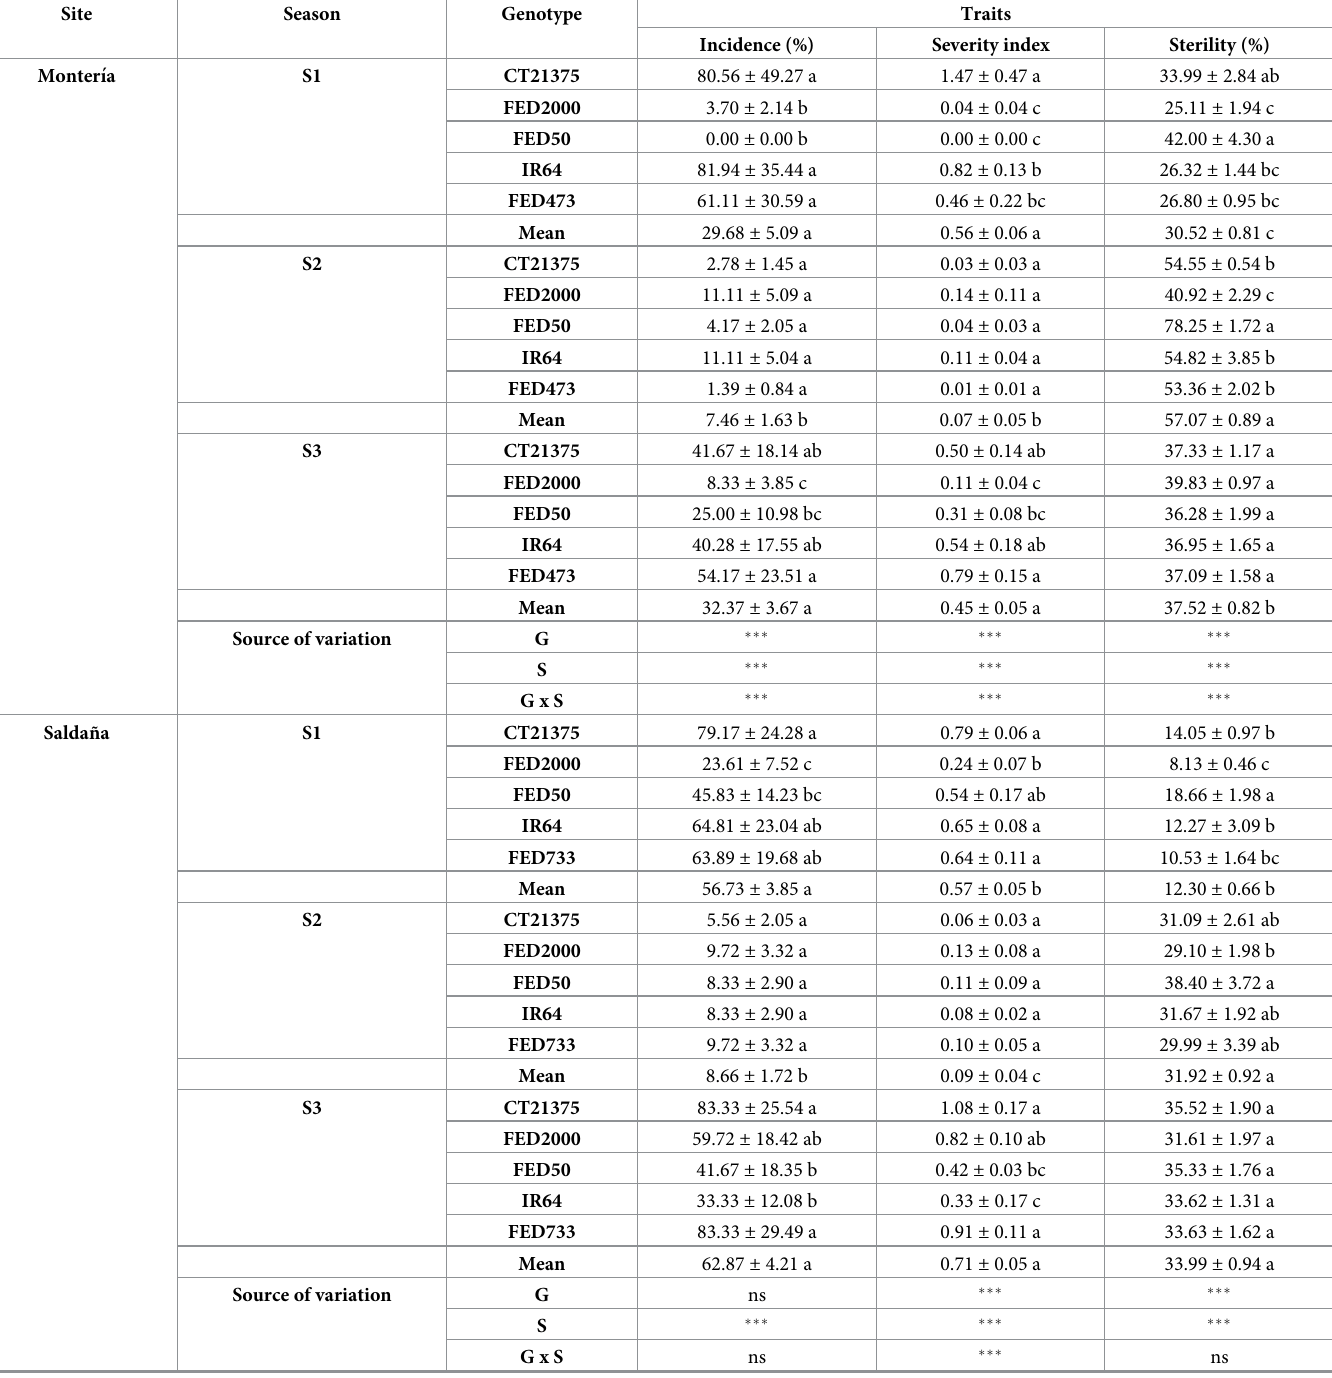
Table 3. Analysis of incidence, severity index, and sterility obtained during three different seasons and sites.